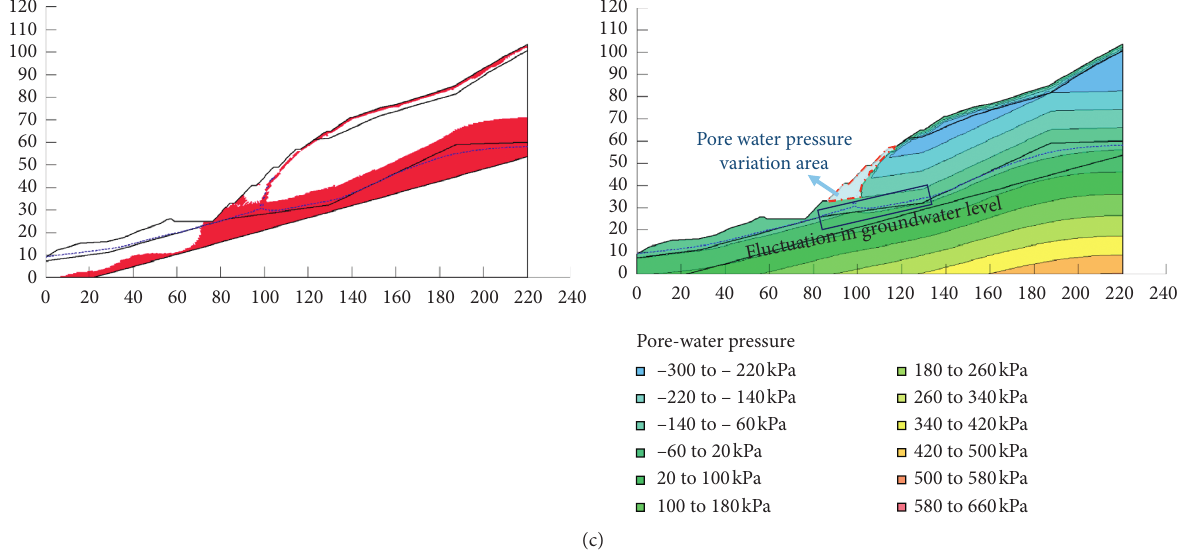
Figure 10: Plastic zone distribution and pore water pressure contour of the slope after rainfall with the type of (a) single-peak; (b) wave; (c)